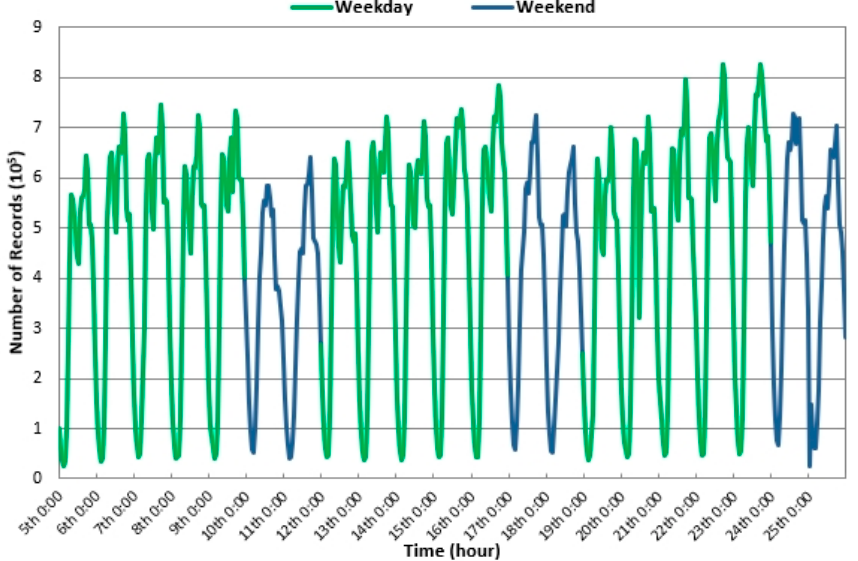
Figure 2. The number of Global Positioning System (GPS) records in three weeks.